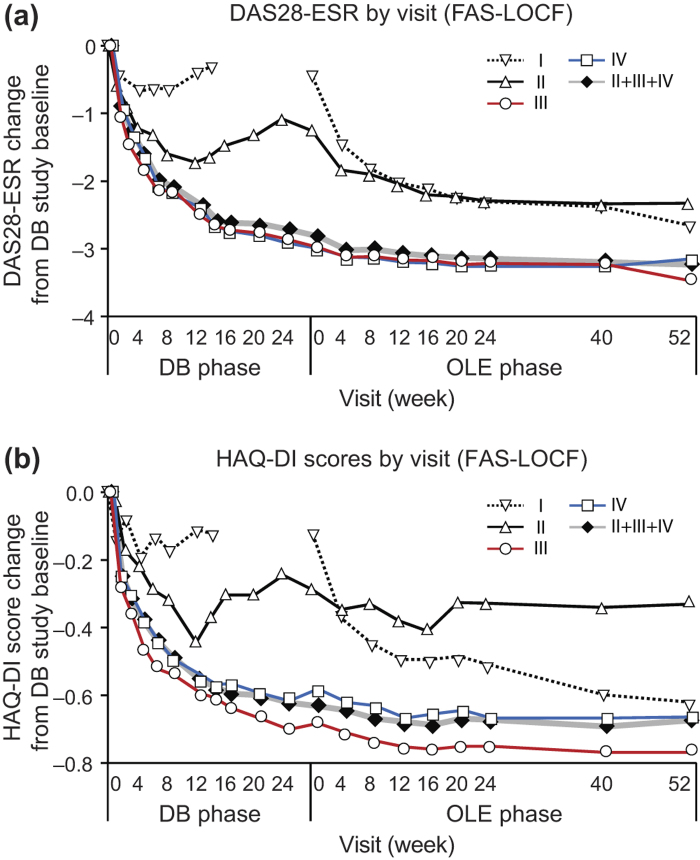
The changes of DAS28-ESR and HAQ-DI over J-RAPID pre-study baseline in patients from each treatment group. Changes in (a) DAS28-ESR and (b) HAQ-DI from J-RAPID pre-study baseline of Groups I (n = 81), II (n = 19), III (n = 93), IV (n = 92) and patients in Groups II + III+ IV combined (DB completers, n = 204) were plotted against time for the DB and the OLE phase of the study (FAS population, LOCF imputation). Of note, week 0 of the OLE phase of Group I (early escape) corresponds to week 16 of the DB phase. There are no points in the missing section of the graph for Group I.